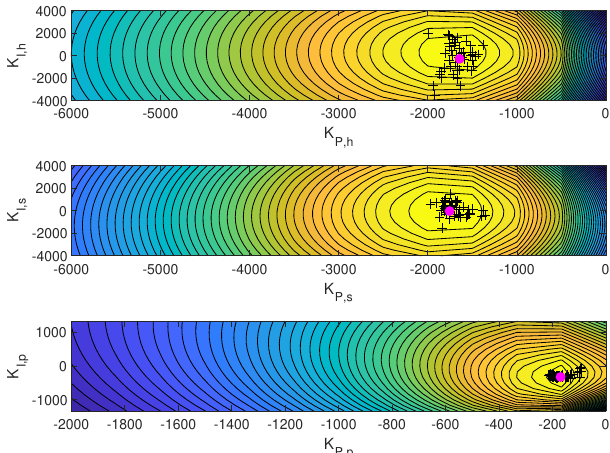
Fig. 12: The P abs surface, fifty realizations of impedance model Z error with 20% uncertainties on inertia, spring, and damping terms for sea-state